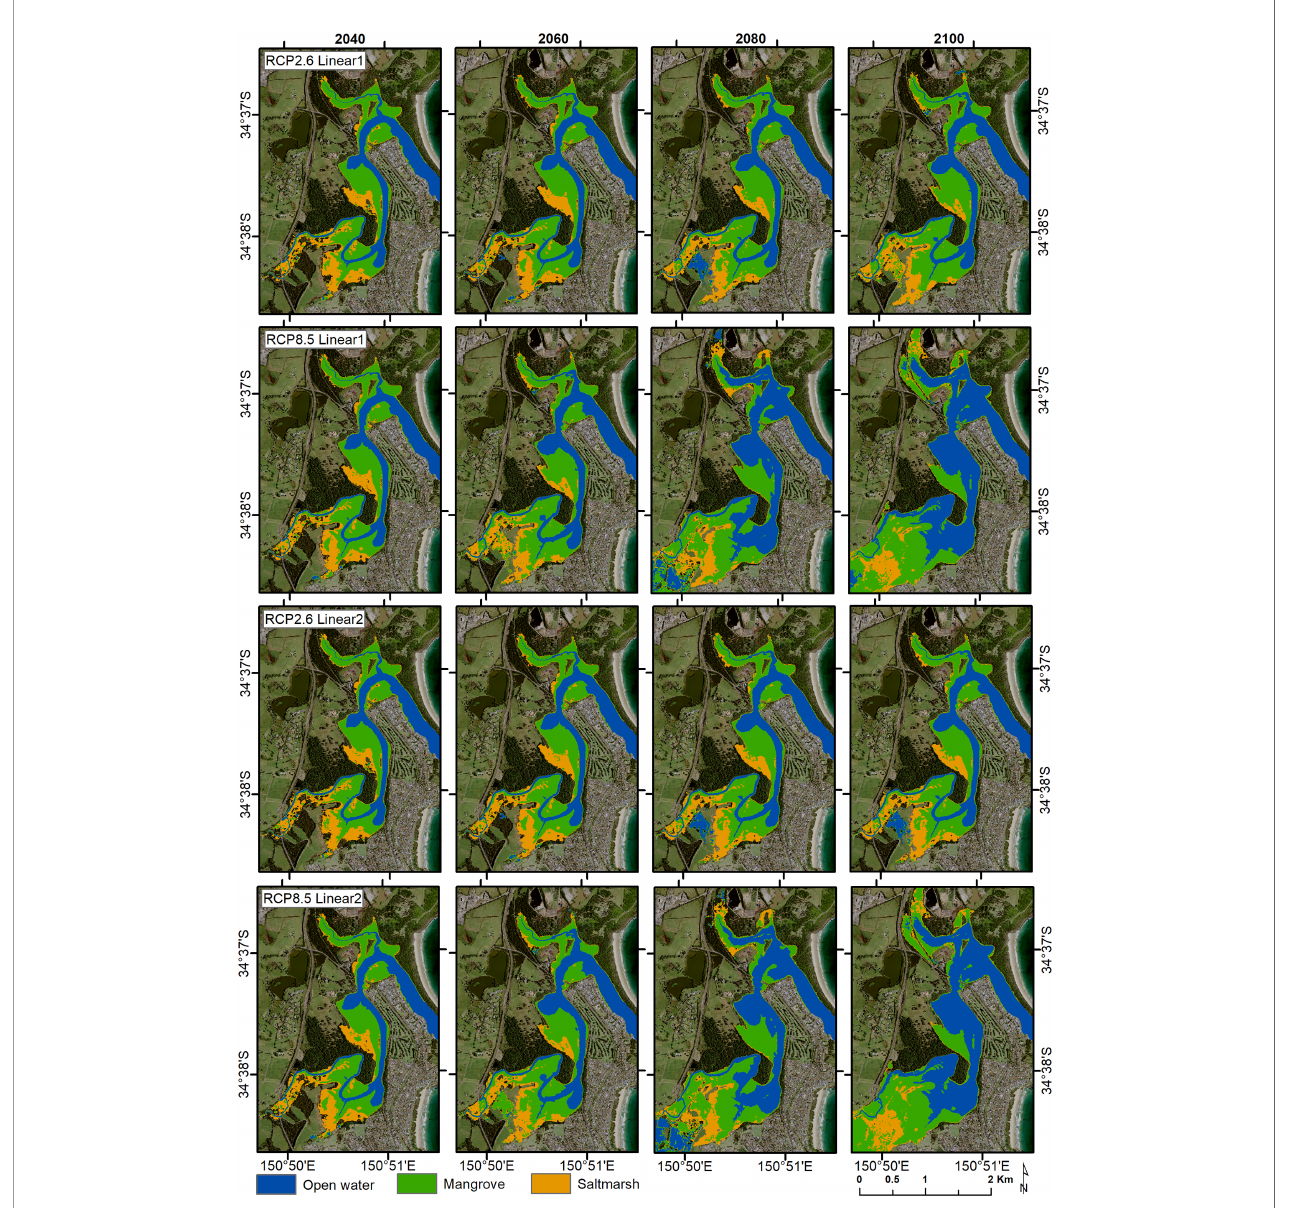
FIGURE 9 | Projections of intertidal wetland vegetation communities (mangrove and saltmarsh) for low and high SLR scenarios, as well as WEM scenarios Linear 1 and Linear